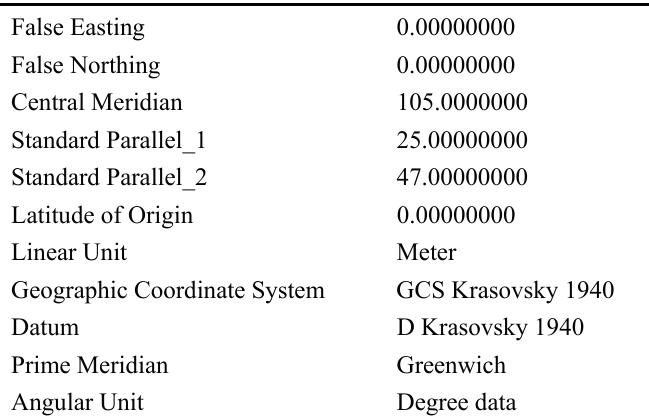
Table 1. Parameters of Albers